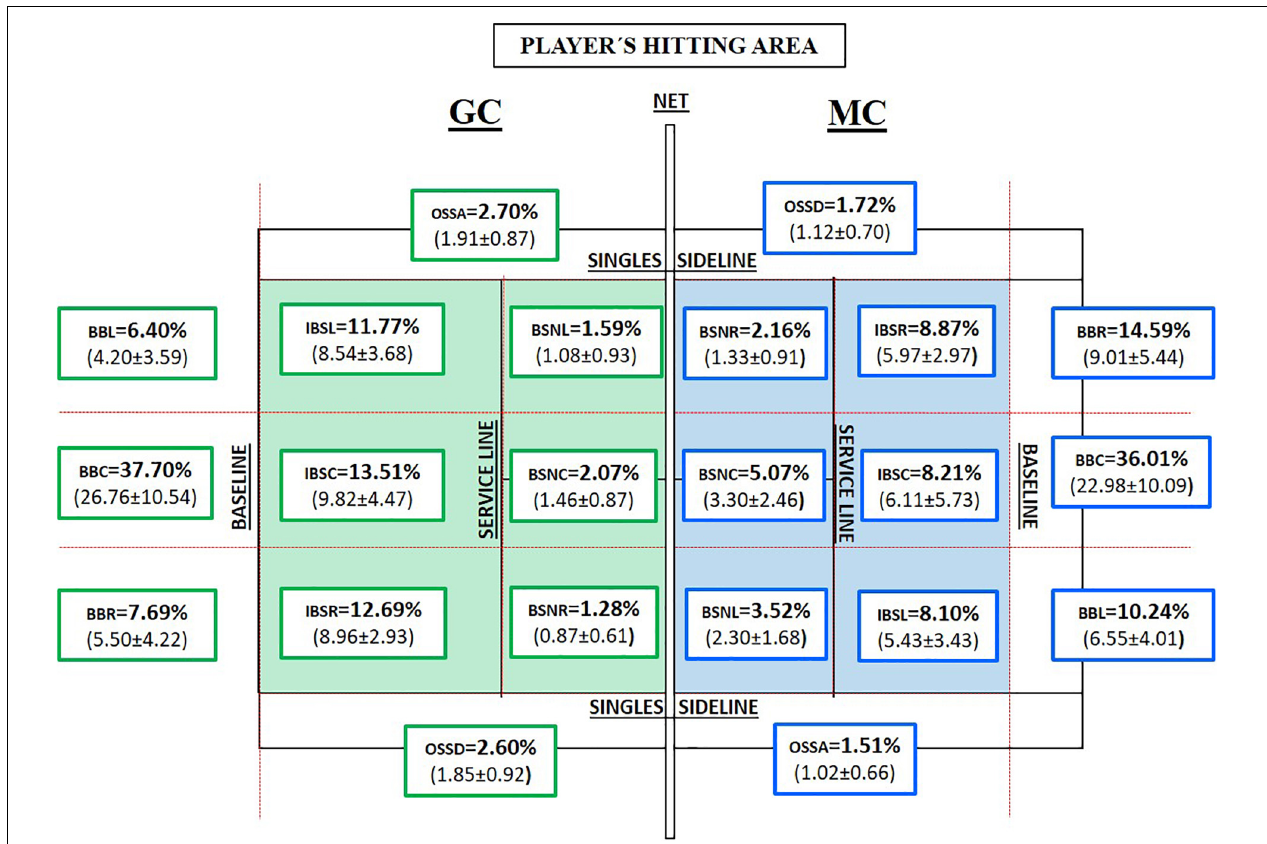
FIGURE 2 | Percentage and mean of the tennis players’ hitting area per match in both competitions (Tennis 10s Green Competition “GC” = green color and Modified Competition “MC” = blue color). BBR, behind the baseline in the right area; BBC, behind the baseline in the central area; BBL, behind the baseline in the left area; IBSR, inside the court behind the service line in the right area; IBSC, inside the court behind the service line in the central area; IBSL, inside the court behind the service line in the left area; BSNR, between the service line and the net right area; BSNC, between the service line and the net central area; BSNL, between the service line and the net left area; OSSD, out from the singles sideline on the deuce side; OSSA, out from the singles sideline on the advantage side.